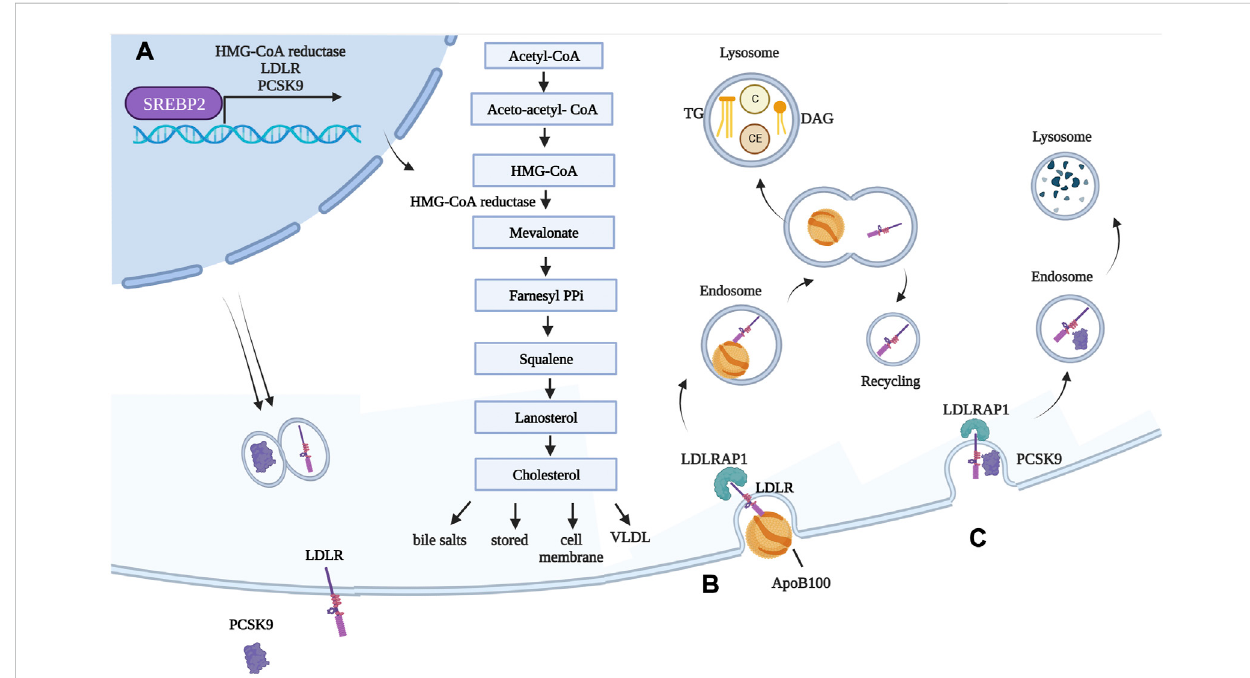
FIGURE 2 Genes involved in FH and their functions in normal conditions. (A) Transcription factor SREBP-2 is responsible for expression of HMG-CoA reductase,aswellasLDL-RanditsmodulatorPCSK9.Oncetranslated,LDL-Risexposedonhepatocytecellmembranes,whilePCSK9issecretedintothe circulation. HMG-CoA reductase converts HMG-CoA into mevalonate. This is the rate-limiting step during cholesterol synthesis, and the enzyme is inhibited by statins. Newly synthetized cholesterol is then i) stored as cholesterol ester, ii) used for cell membranes, iii) used for generating bile salts, and iv) packaged into VLDL. (B) LDL is internalized into hepatocytes (and extra-hepatic tissues) following interaction between ApoB100, a structural component of LDL, and LDL-R. LDLRAP1 mediates internalization of LDL-R, which occurs through clathrin-mediated endocytosis. The early acidic endosome environment induces disassociation of LDL-R and LDL, with the former being recycled back onto the cell membrane. As LDL-containing endosomes mature in lysosomes, LDLs are subjected to the action of lysosomal enzyme, and their components are released. (C) PCSK9 binds to LDL-R exposed on cell membranes. Because of the tight interaction between the two, in this case, the whole complex is targeted to the lysosome for degradation. Created with BioRender.com. C = cholesterol; CE = cholesterol esters; DAG =